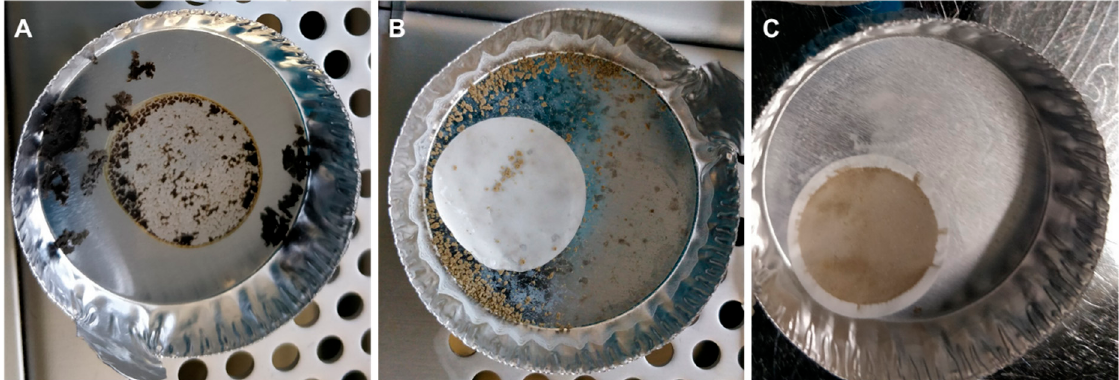
Figure 9. The end result of the gravimetric analysis done on 2 mL of sludge. ( A ): dried sludge (surrogate) ( B ): dried retentate and filter after hydrogen peroxide treatment, ( C ): dried retentate and filter after Fenton treatment.